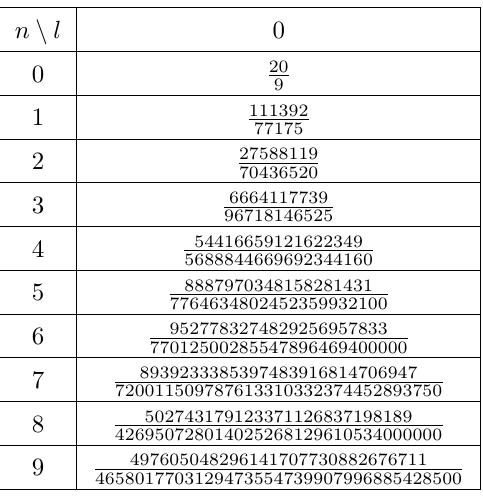
Table 1 . OPE coefficients C (2)